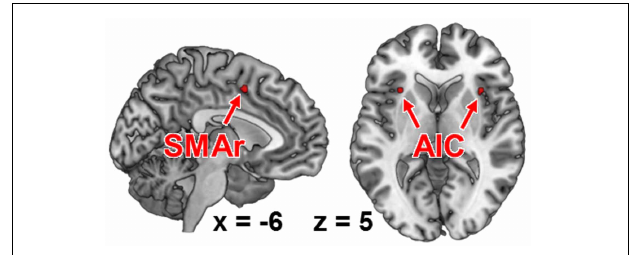
FIGURE 2 | Functional intersection of all co-activation maps of each fMRI-based seed region, as revealed by meta-analytic connectivity modeling. These regions represent those brain areas that were functionally connected to all of our seed regions (i.e., task-general regions). AIC, anterior insular cortex; SMAr, rostroventral supplementary motor area.